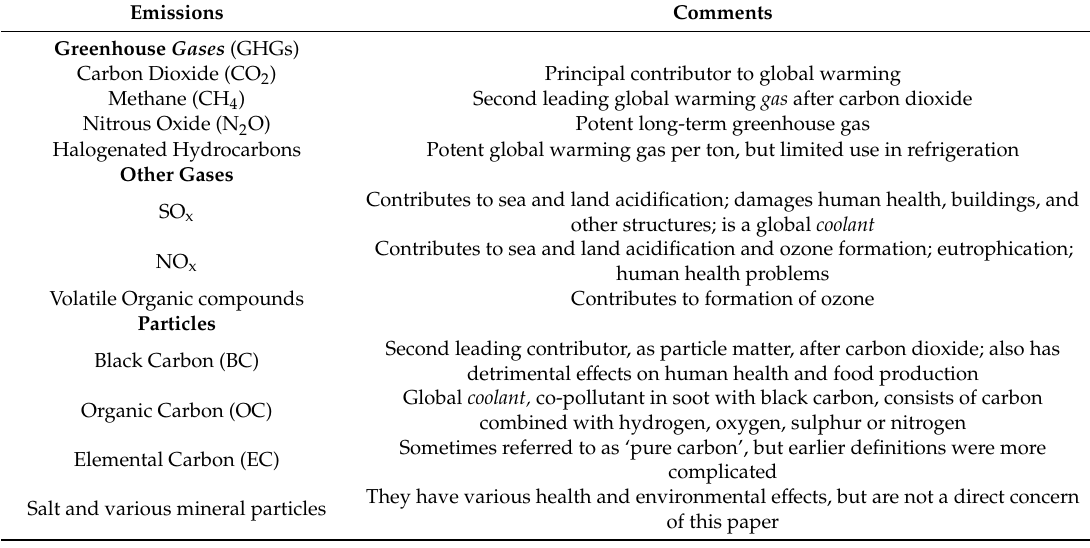
Table 1. Maritime Ships’